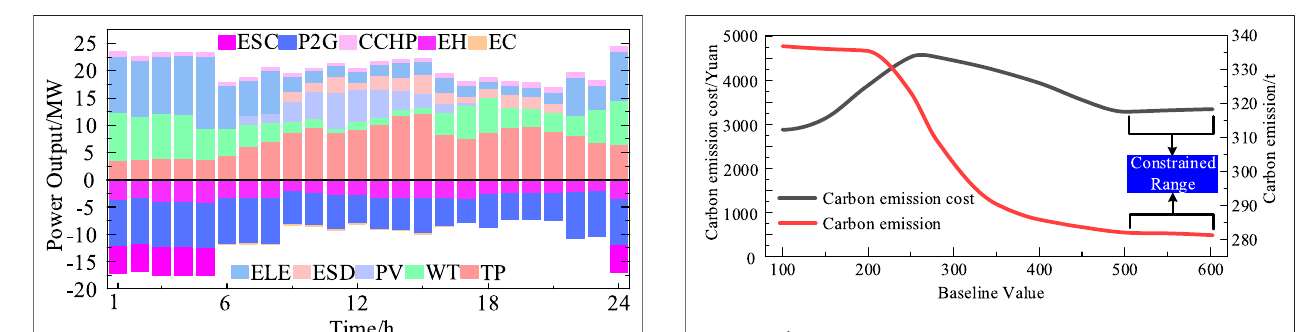
FIGURE 8 | Impact of the baseline value c of the CEUC on carbon emissions and carbon emission